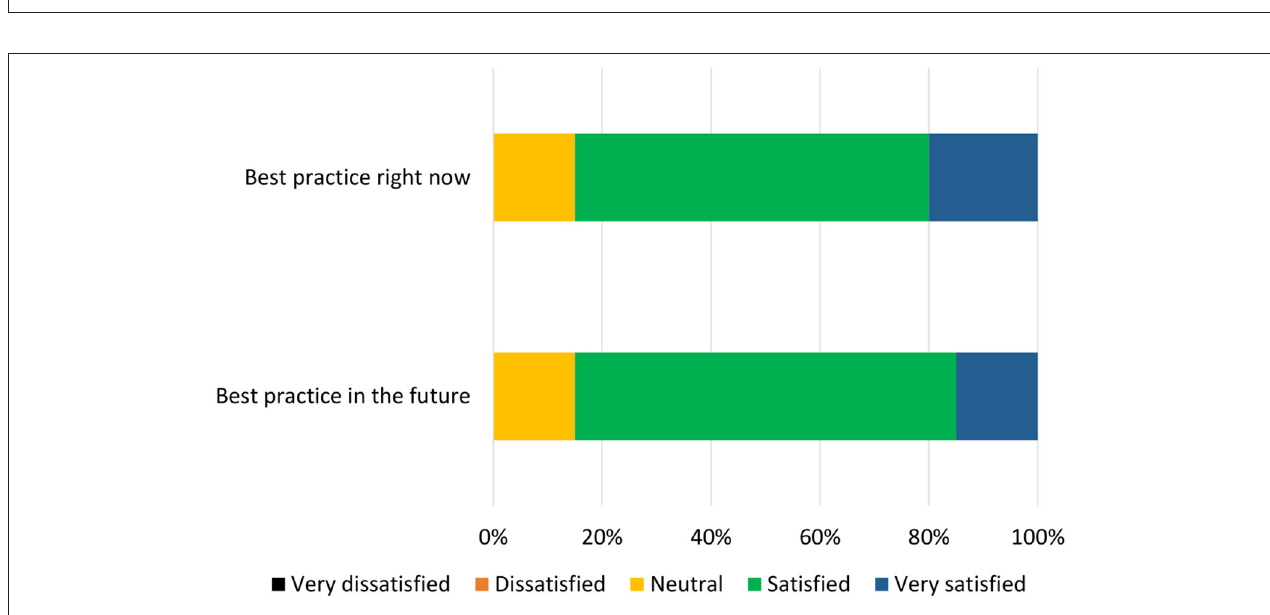
FIGURE 5 | Participant satisfaction with the checklist during Phase 3 ( n =